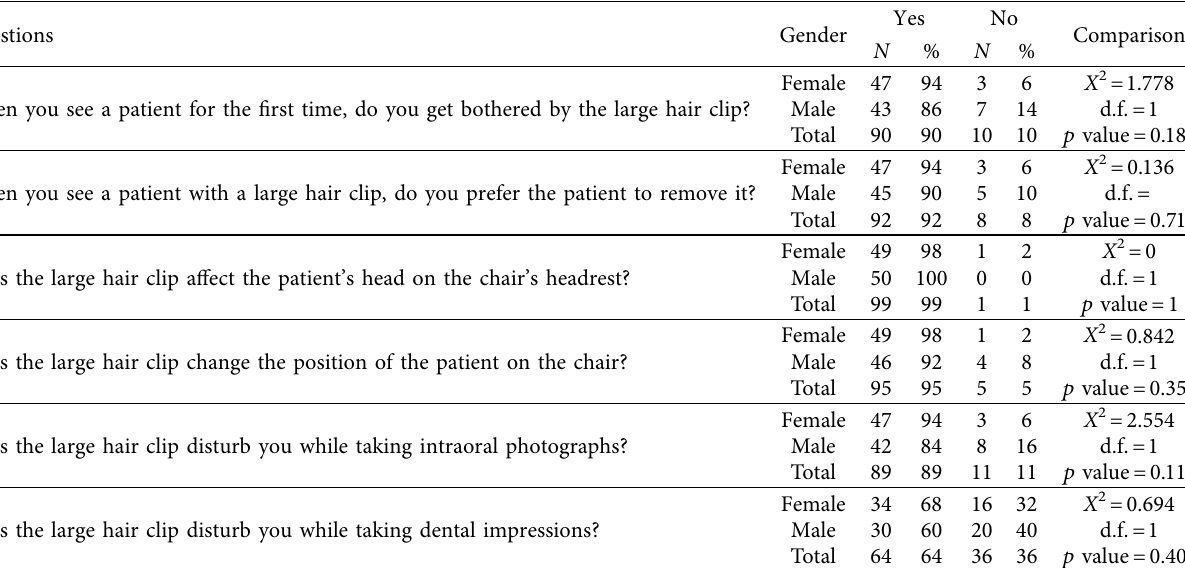
Table 1: Orthodontists’ responses to the online questionnaire with gender difference.